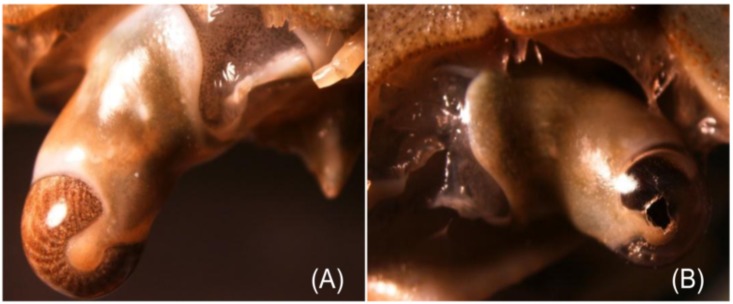
Injury to the eye of Callinectes sapidus after an attack by Octopus maya.A) Normal physiognomy of the peduncle eye (stereoscopic microscope 3X). B) Injury to the rostrum of a crab attacked by O. maya (stereoscopic microscope 3X).